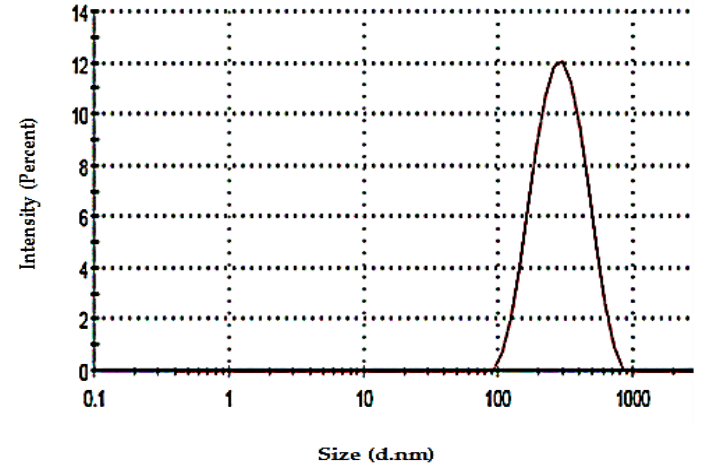
Figure 9. Particle size distribution curve of the optimized SV-loaded SNVs (F8). Abbreviations: SV, Sodium valproate.